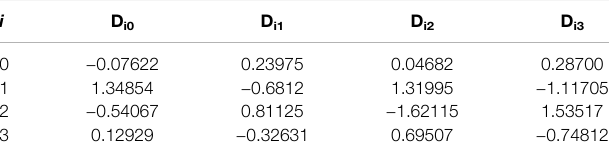
TABLE 12 | Coef fi cients D ij of η ( ρ , T )